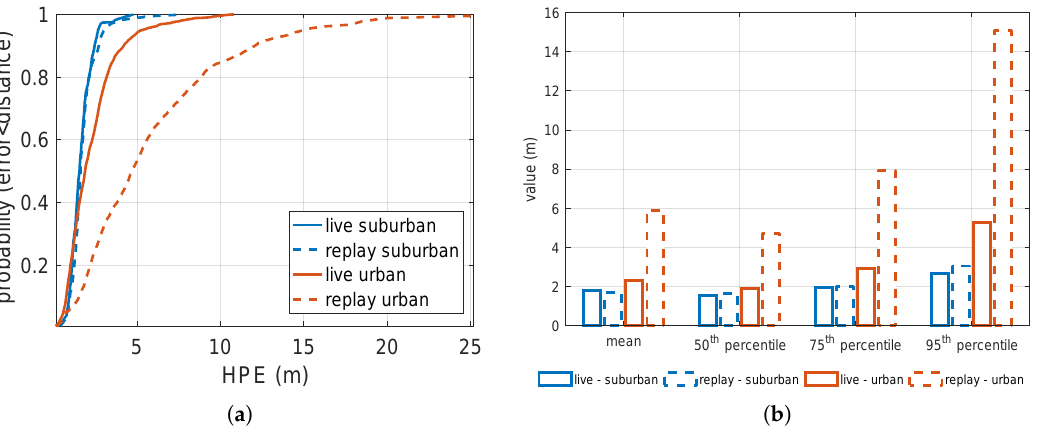
Figure 10. Statistical characterization of the HPE. ( a ) Cumulative distribution functions (CDFs) and ( b ) additional